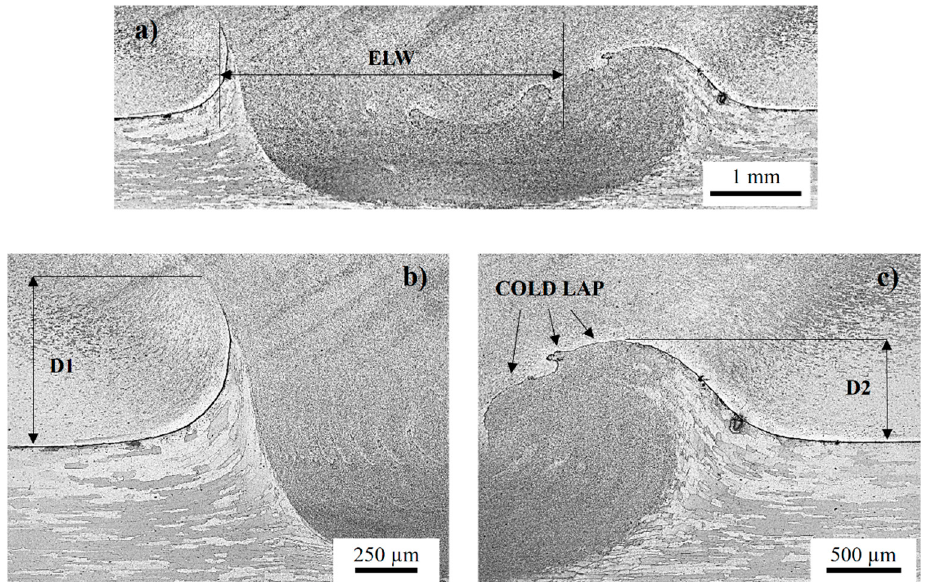
Figure 3. Example of hook and cold lap defects and their characteristic measurements in a friction stir welding (FSW) lap joint: ( a ) effective lap width (ELW); ( b ) hook height at the advancing side (D1); and ( c ) cold lap defect and hook height at the retreating side (D2). Tool translation movement was forward from the shown cross-section.